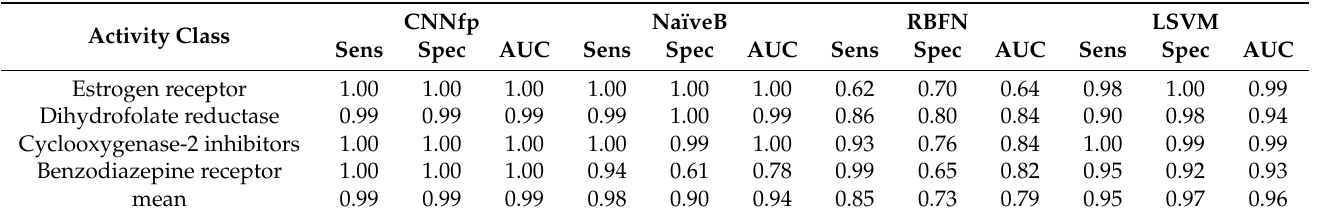
Table 4. Sensitivity, specificity, and AUC values for the prediction models using a Sutherland